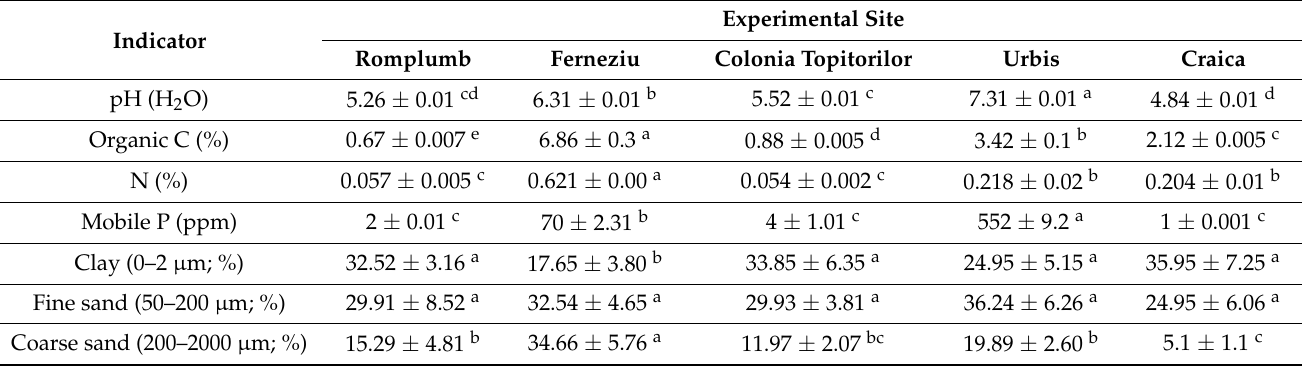
Table 2. Soil chemical composition.